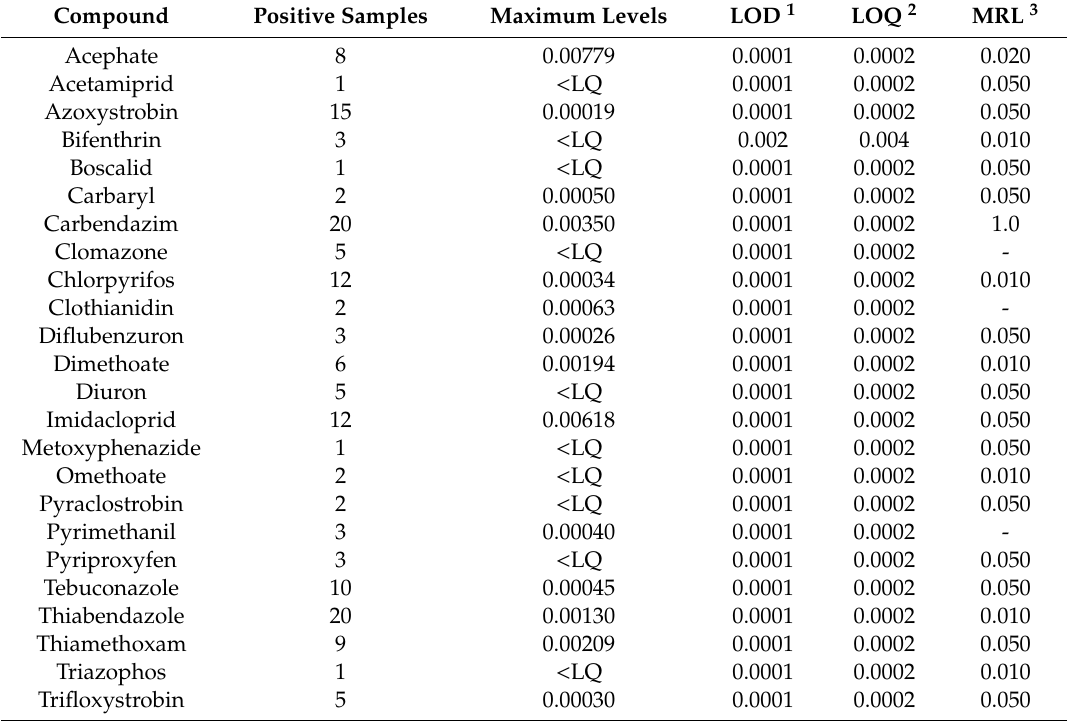
Table 5. Detected pesticides (in mg / kg) in 33 samples of honey using the developed LC-MS / MS and GC-MS / MS